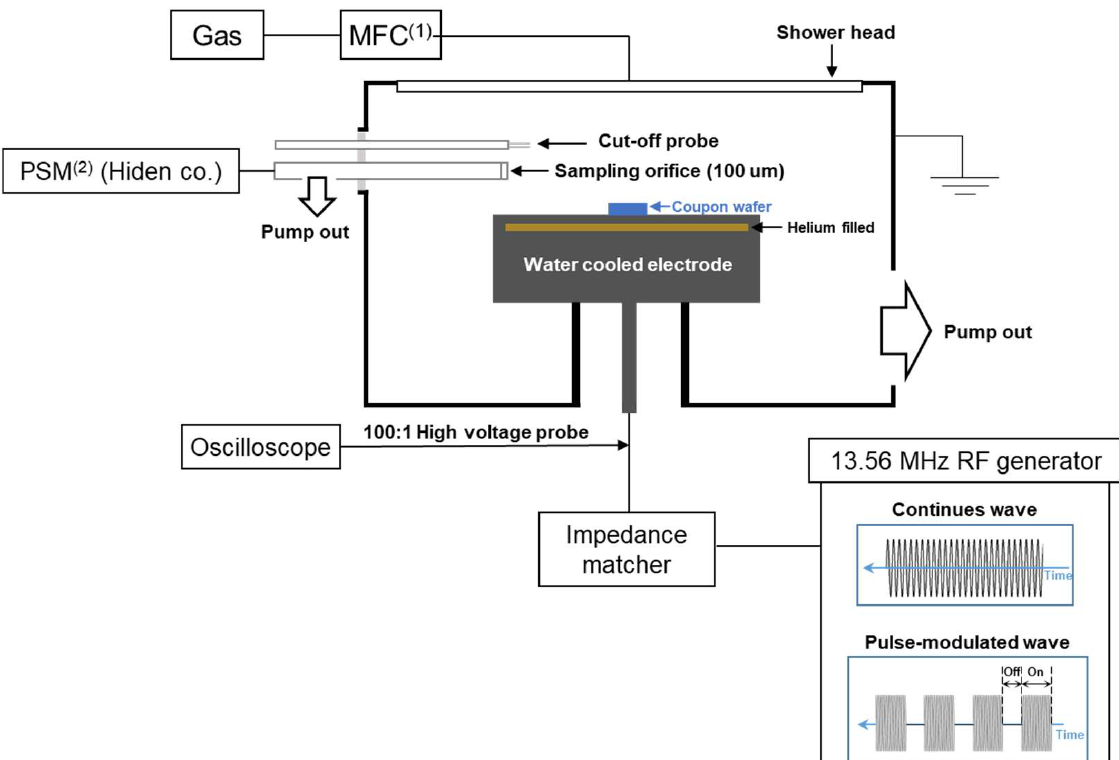
Figure 1. Experimental setup. (1) Mass flow controller, (2) Plasma sampling mass spectroscopy.